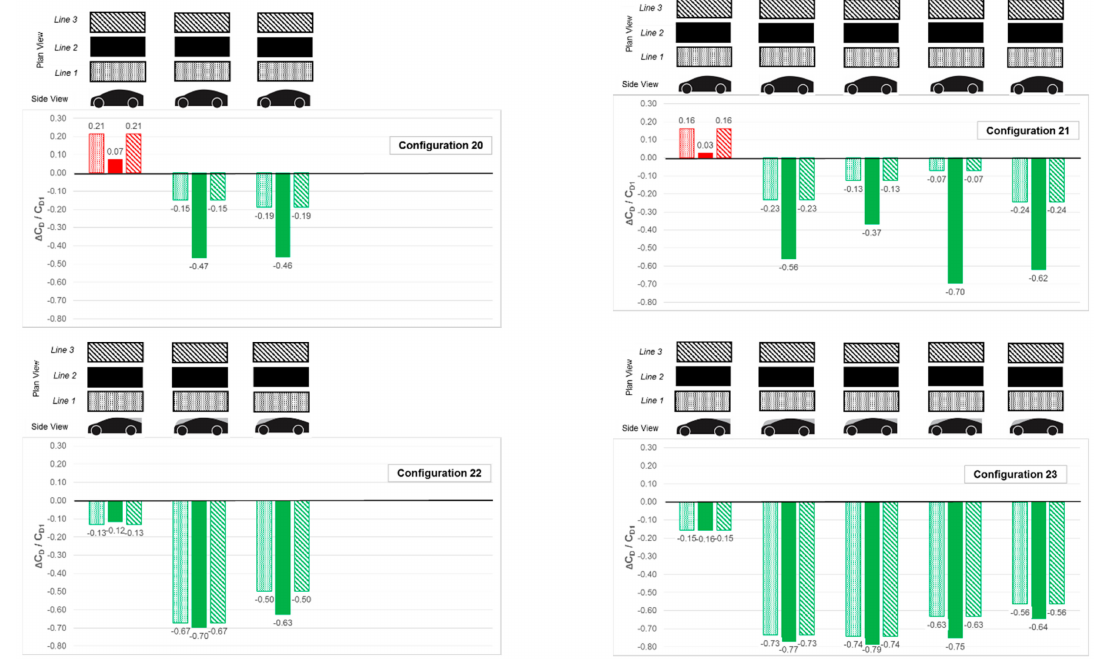
Figure 11. Triple-Line configurations consisting of platoons 3-model and 5-model lines of homogeneous B1-style models (Configurations 20 and 21), and also suitable combinations of B2, B3, and B4-styled models (Configurations 22 and